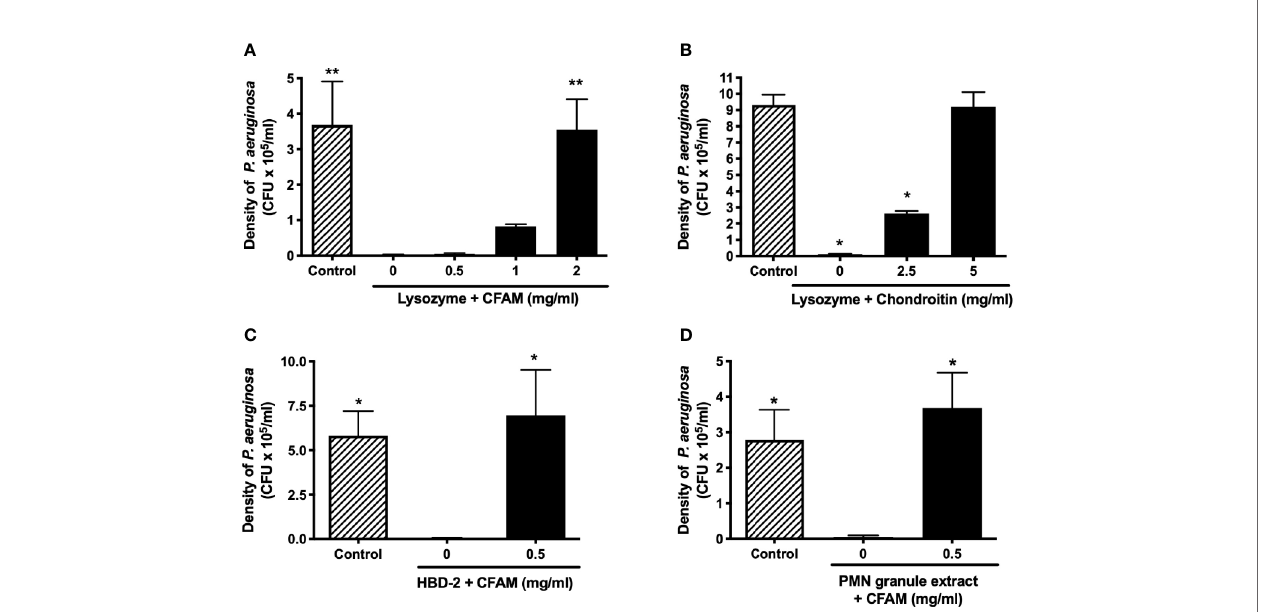
FIGURE 6 | Effect of mucins on non-oxidative killing by cationic peptides and proteins. (A) Recombinant human neutrophil lysozyme (6 µg/ml) effectively killed P. aeruginosa bacteria and (B) the addition of chondroitin to lysozyme protected bacteria (n = 4). Airway mucins puri fi ed from CF mucus also protected P. aeruginosa against killing by (C) 4 µg/ml of HBD-2 and (D) neutrophil granule extracts containing 8 µg/ml of lysozyme (n = 4 (*p < 0.05, **p <